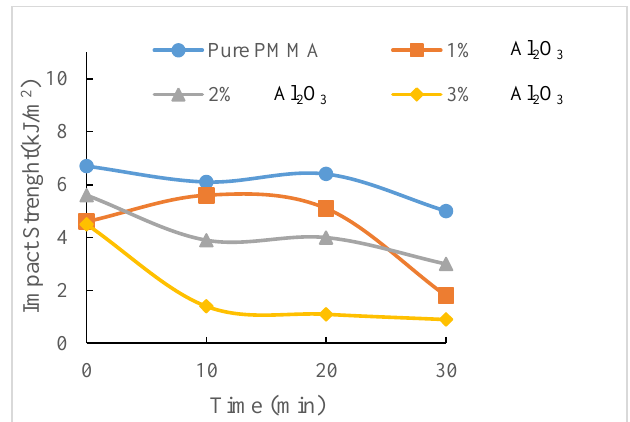
Fig.5: Influence of immersion nanocomposite PMMA + (1%, 2%, 3% of Al water for (10, 20, 30 min), respectively.